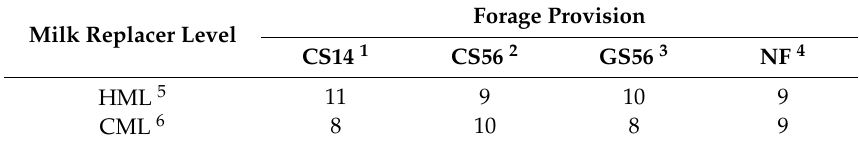
Table 1. Number of calves allocated to each treatment. Forage Provision Milk Replacer Level CS14 1